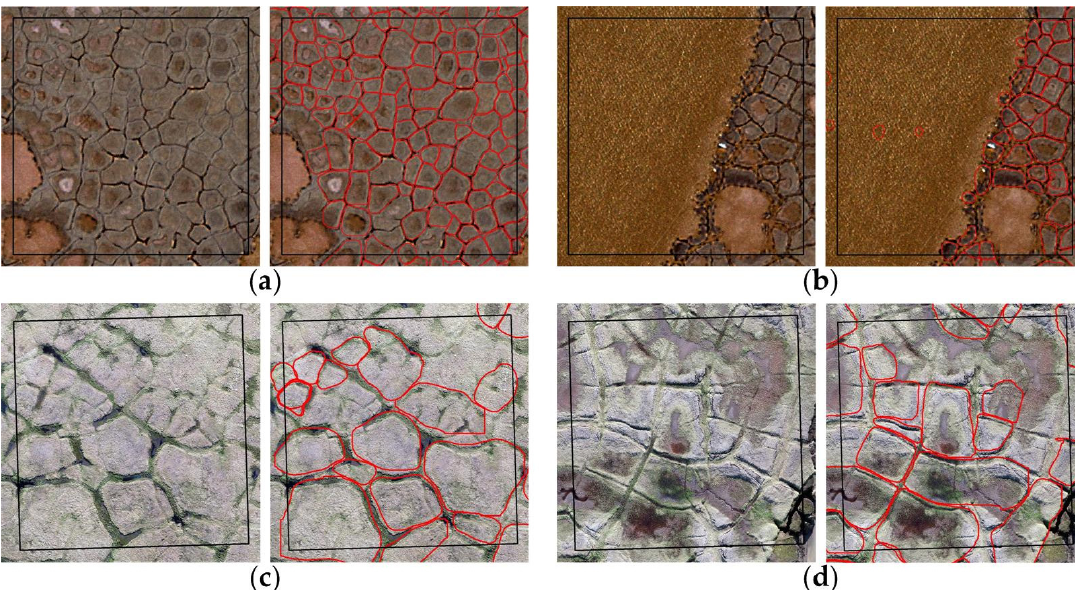
Figure 3. Examples of the ice-wedge polygons (IWP) detection and delineation results for expert-based qualitative assessment; ( a , b ): results of the IWP detection and delineation using the sub-meter resolution satellite image (Imagery © [2015] DigitalGlobe, Inc.); ( c , d ): results of the IWP detection and delineation using the unmanned aerial vehicle (UAV)